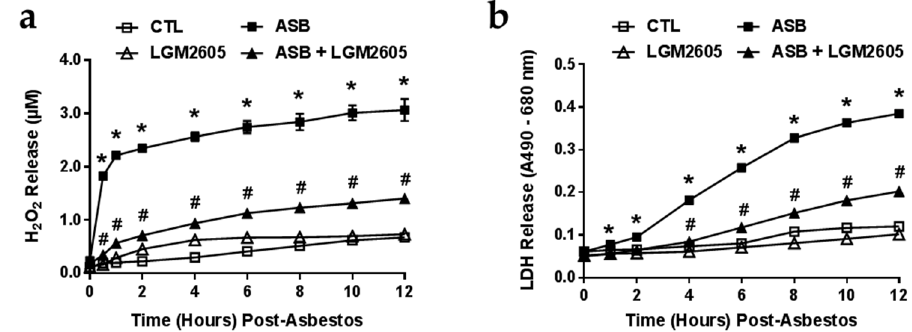
Figure 3. ROS Production and Cytotoxicity Following Asbestos Exposure. Elicited murine peritoneal macrophages were plated in a 6-well plate (2 × 10 6 cells/well) and exposed to 50 µM synthetic SDG (LGM2605) 4-h prior to exposure to sterile UICC crocidolite (SPI Supplies) asbestos fibers (20 µg/cm 2 ). ( a ) Murine peritoneal macrophage release of H 2 O 2 ( b ) and lactate dehydrogenase (LDH) was determined at 0, 1, 2, 4, 6, 8, 10 and 12-h post asbestos exposure. Samples were run undiluted in triplicate and data are presented as mean ± the standard error of the mean (SEM). * indicates a statistically significant difference (p < 0.05) between asbestos-only (ASB) and control (CTL) treated cells; # indicates a statistically significant difference ( p < 0.05) between ASB and asbestos + LGM2605 (ASB + LGM2605) treated cells.